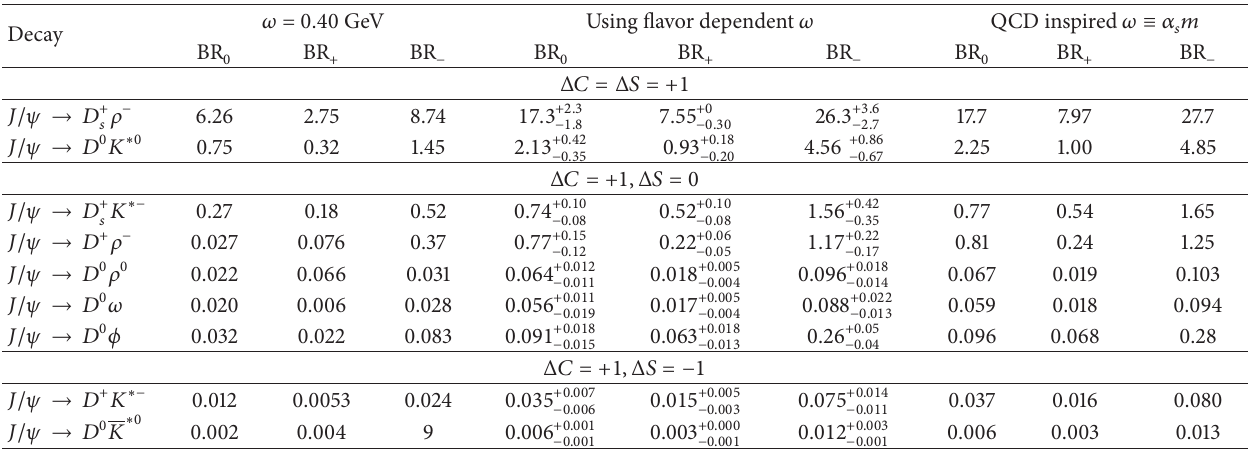
Table 6: Branching Ratios BR 0 , BR − and BR + corresponding to the Helicity amplitudes 𝐻 0 and 𝐻 ±1 (in the units of 10 −10 ) of 𝐽/𝜓 → 𝑃𝑉 decays.